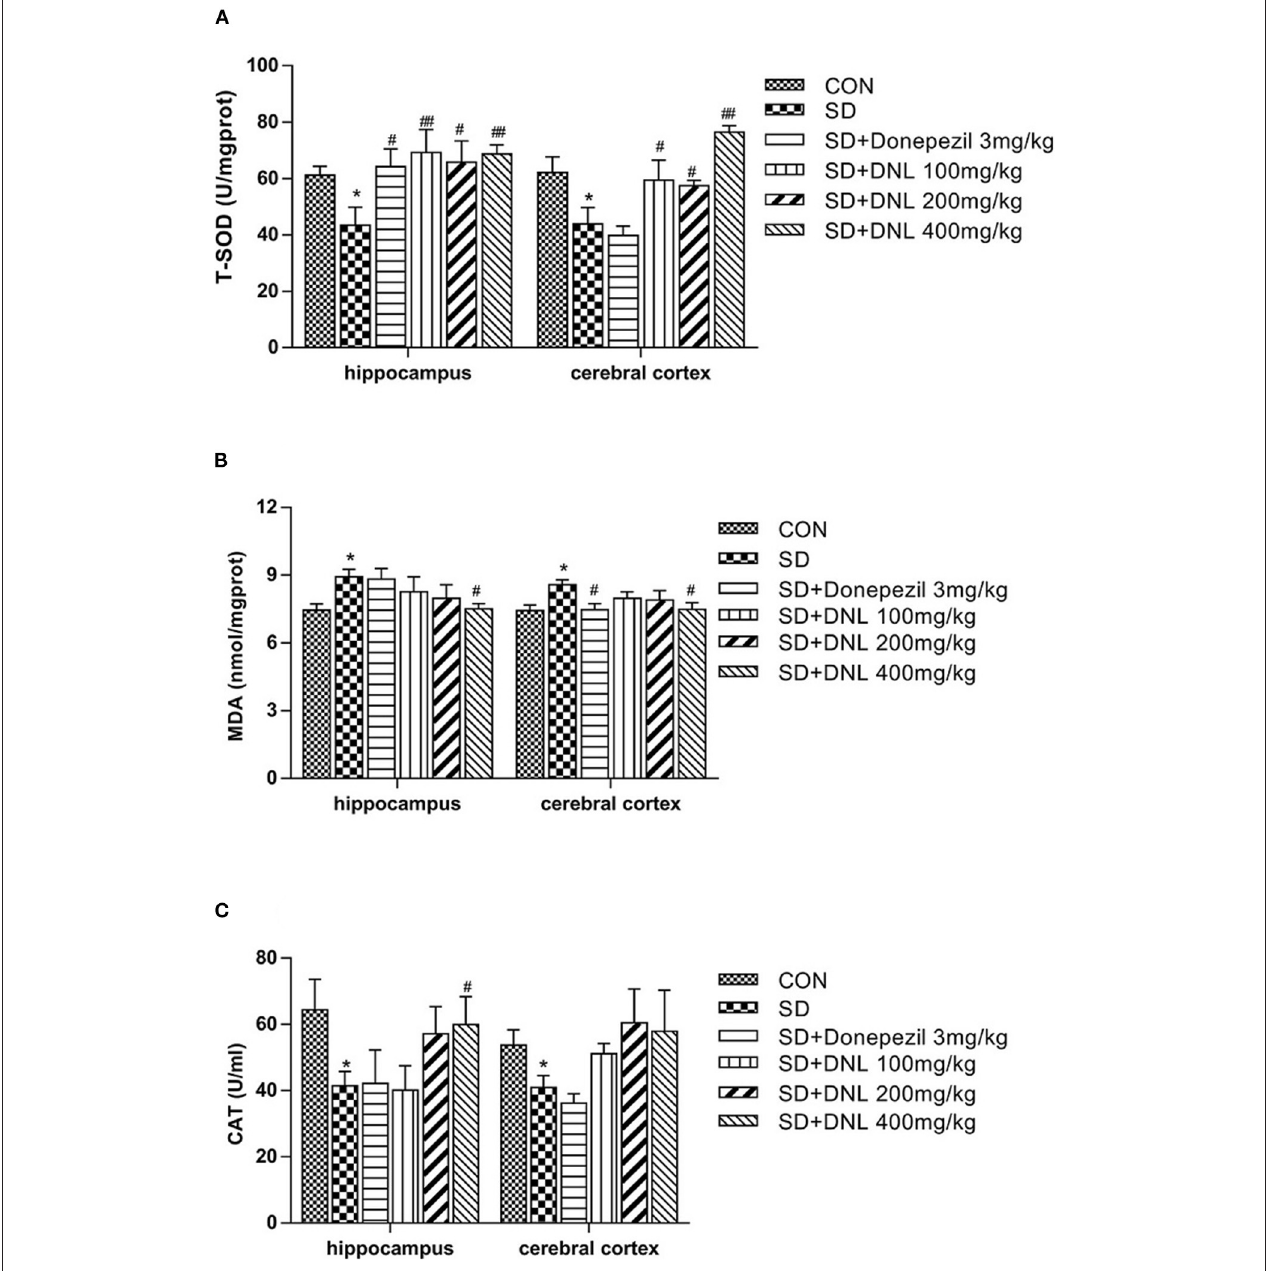
FIGURE 8 | The effect of DNL on the activities of Total Superoxide Dismutase (T-SOD) (A) ; Catalase (CAT) (B) and Malonaldehyde (MDA) (C) in the hippocampus and cerebral cortex of mice after SD for 2 weeks. Values are mean ± SEM, n = 8. * p < 0.05 vs. the Con group; # p < 0.05 vs. the SD group, ## p < 0.01 vs. the SD